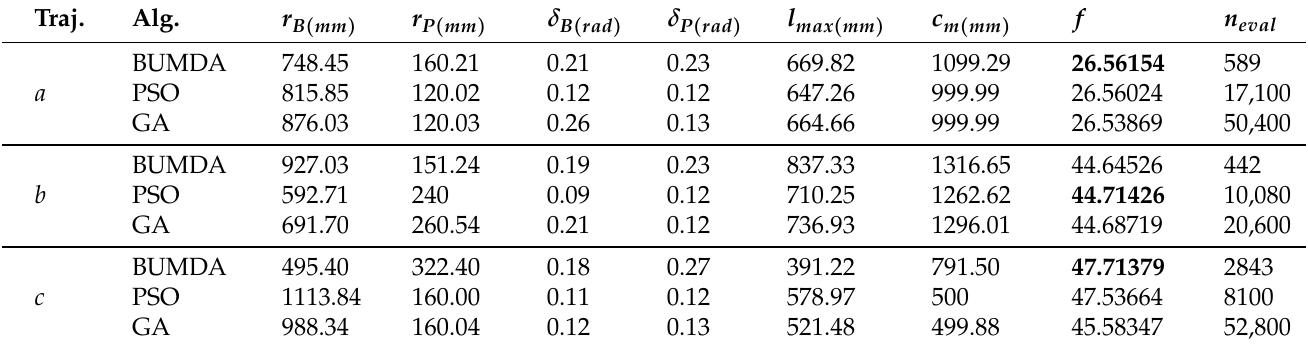
Table 2. Mono-objective optimization results: the optimized parameters and best objective function values from 15 independent executions of each